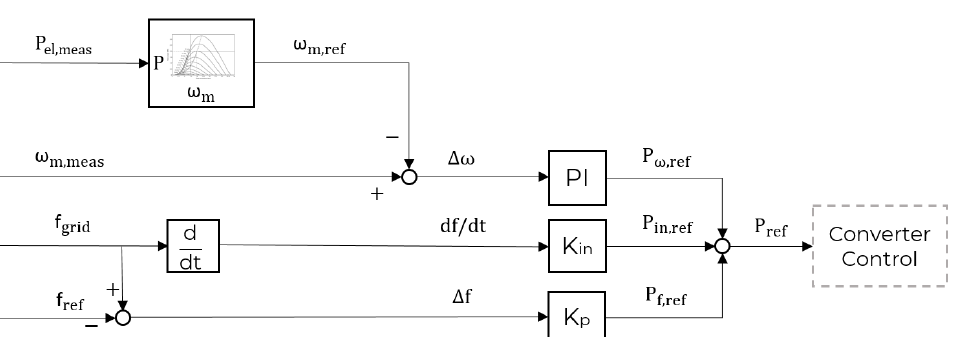
Figure 1. Inertial and primary frequency support control scheme